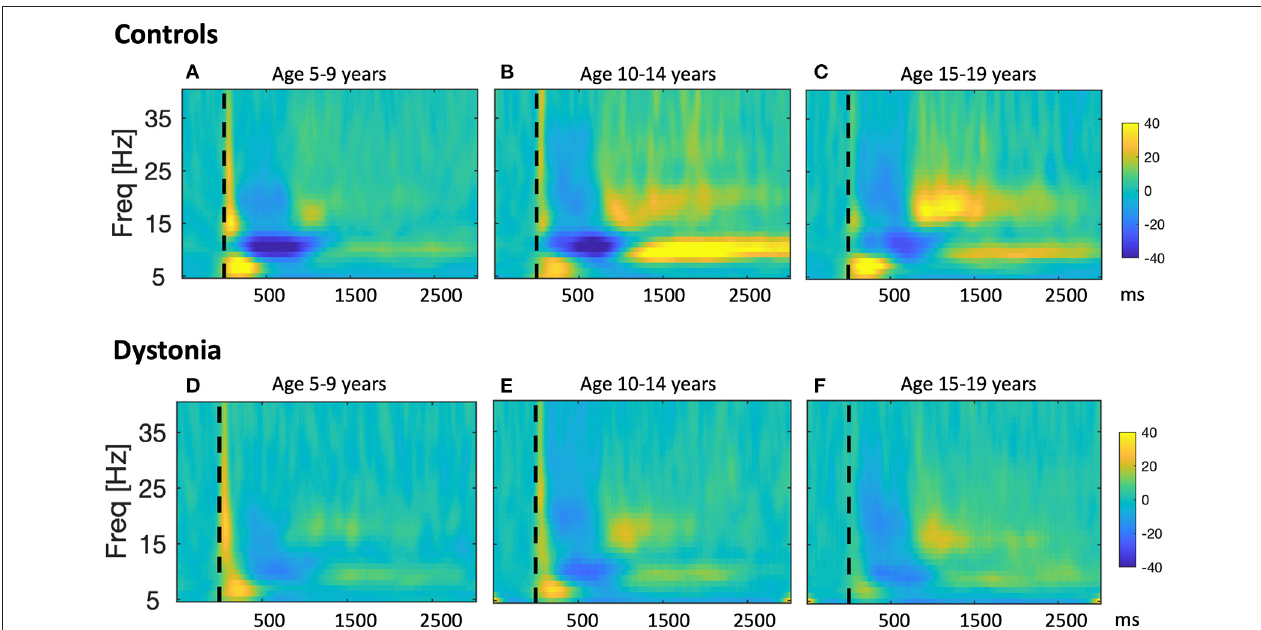
FIGURE 3 | Developmental sequence of event-related changes in EEG power in relation to a proprioceptive stimulus in typically developing children and children with dystonia. Results from a study in which changes in sensorimotor cortex EEG were recorded in response to proprioceptive stimuli in 30 young people with dystonia and 22 controls ( 20). Participants sat at a table with their arm positioned in the arm-rest of a robotic wrist interface which delivered controlled passive wrist extension movements, resulting in brief stretches of the wrist flexors, with rise-time of 240ms, and a target of 12 ◦ from the neutral position. Up to 160 wrist extension movements were recorded for each hand. Scalp EEG was recorded using a BrainVision system (BrainAmp MR Plus) and stimulus timing was synchronized with the EEG recordings via an electrical marker designating the movement onset. Offline, data were segmented into epochs comprising 1s pre-stimulus and 3.5s post-stimulus. After artifact rejection, remaining epochs were averaged to produce a stretch evoked potential for each hand in each subject. EEG power was calculated in 1Hz bins from 5 to 40Hz using the continuous Morlet wavelet transform with eight wavelet cycles. Relative changes in post-stimulus EEG power with respect to the pre-stimulus period were calculated. The figure shows pooled time-frequency plots across subjects showing the response over the contralateral hemisphere to stretch of the dominant hand wrist flexors i.e., right sensorimotor cortex for left hand movement, left sensorimotor cortex for right hand movement for controls (A–C), and individuals with dystonia (D–F), grouped by age. Left column: Young age group (5–9 years, n = 10), middle column: Intermediate age group (10–14 years, n = 6), right column: Older age group (15–19 years, n = 6). x-axis shows time in ms after the stimulus (dashed vertical line), y-axis shows frequency, color scale shows relative power at each frequency with respect to the pre-stimulus period, such that dark blue indicates event-related desynchronisation (ERD) and yellow-orange indicates event-related synchronization (ERS). The sharp increase in power with respect to baseline at time zero, extending up to 40Hz, and the brief, early increase in theta range (4–7Hz) power from 0 to 300ms are likely to reflect movement artifact and a contribution from the stretch evoked potential, respectively. Figure adapted from McClelland et al.